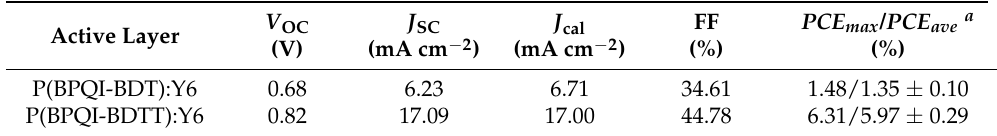
Table 2. Photovoltaic parameters of OSCs based on P(BPQI-BDT):Y6’s and P(BPQI-BDTT):Y6’s active layer. a Average data from 10 independent devices.